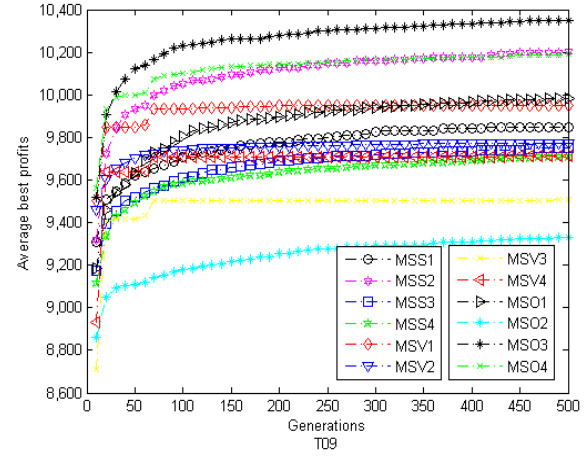
Figure 8. The convergence graph of twelve discrete MS algorithms on S09.